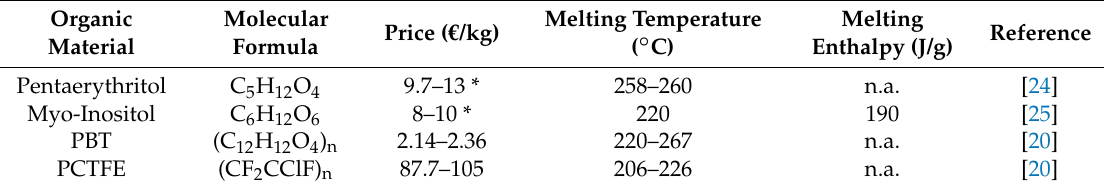
Table 3. Organic PCM candidates with phase change temperature between 210 ◦ C and 270 ◦